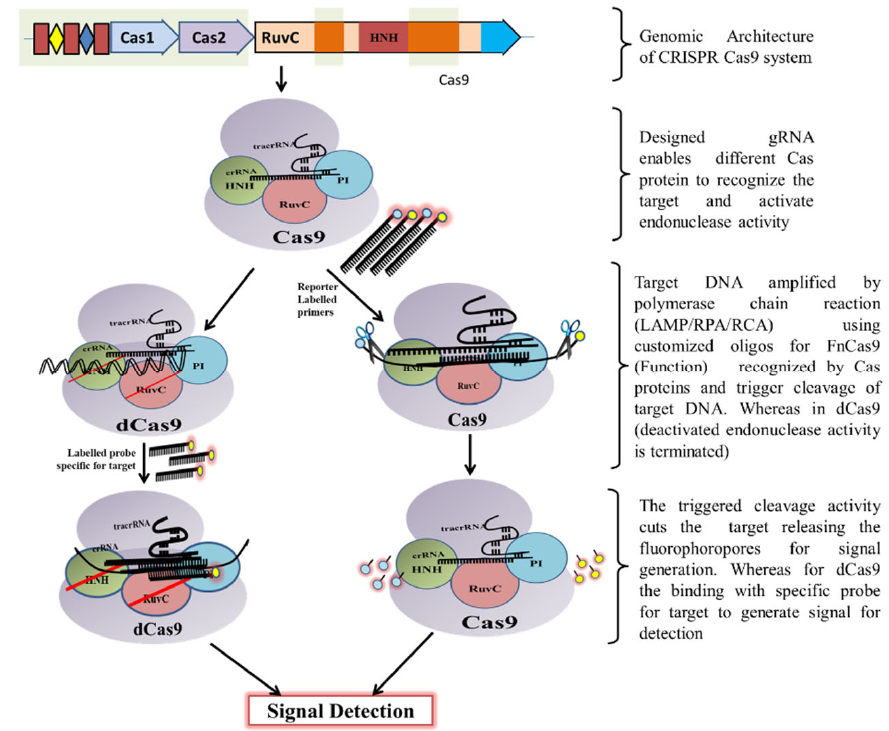
Figure 3. Schematic diagram showing CRISPR/Cas9 mechanism for DNA detection. Cas13 nucleases target ssRNA and are a Type VI CRISPR-Cas signature protein. The exclusion of the tracrRNA requirement is the distinctive feature of Cas13 effectors (HEPN)- binding domains (Figure 4A). Cas13a has been shown to possess dual RNAse activity. First for RNA-activated single-stranded RNA destruction [39,40]. The presence of dual RNase activity of Cas13 is due to the presence of two RNase catalytic pockets, namely the REC lobe (containing 1-helical domain) which cleaves pre-crRNA and the NUC lobe (containing two HEPN domain) that recognize and cleave target RNA [40,41]. The mechanism of cleavage (target (cis) and non-target RNA (trans) lies in the recognition and binding of Cas13 to a protospacer flanking site (PFS) adjacent to the complementary spacer on the 5’ and 3’ ends of the protospacer for Cas13b nuclease, whereas for Cas13a it is present on the 3’ end of ssRNA. The Cas13 endonuclease enzyme with crRNA induces blunt-end breakage and degrades arbitrarily non-target ssRNA present nearby [42]. A recent report demonstrated the dependence of cleavage activity on conserved catalytic residues in the two HEPN domains as well as the preference of uracil residue for cleavage